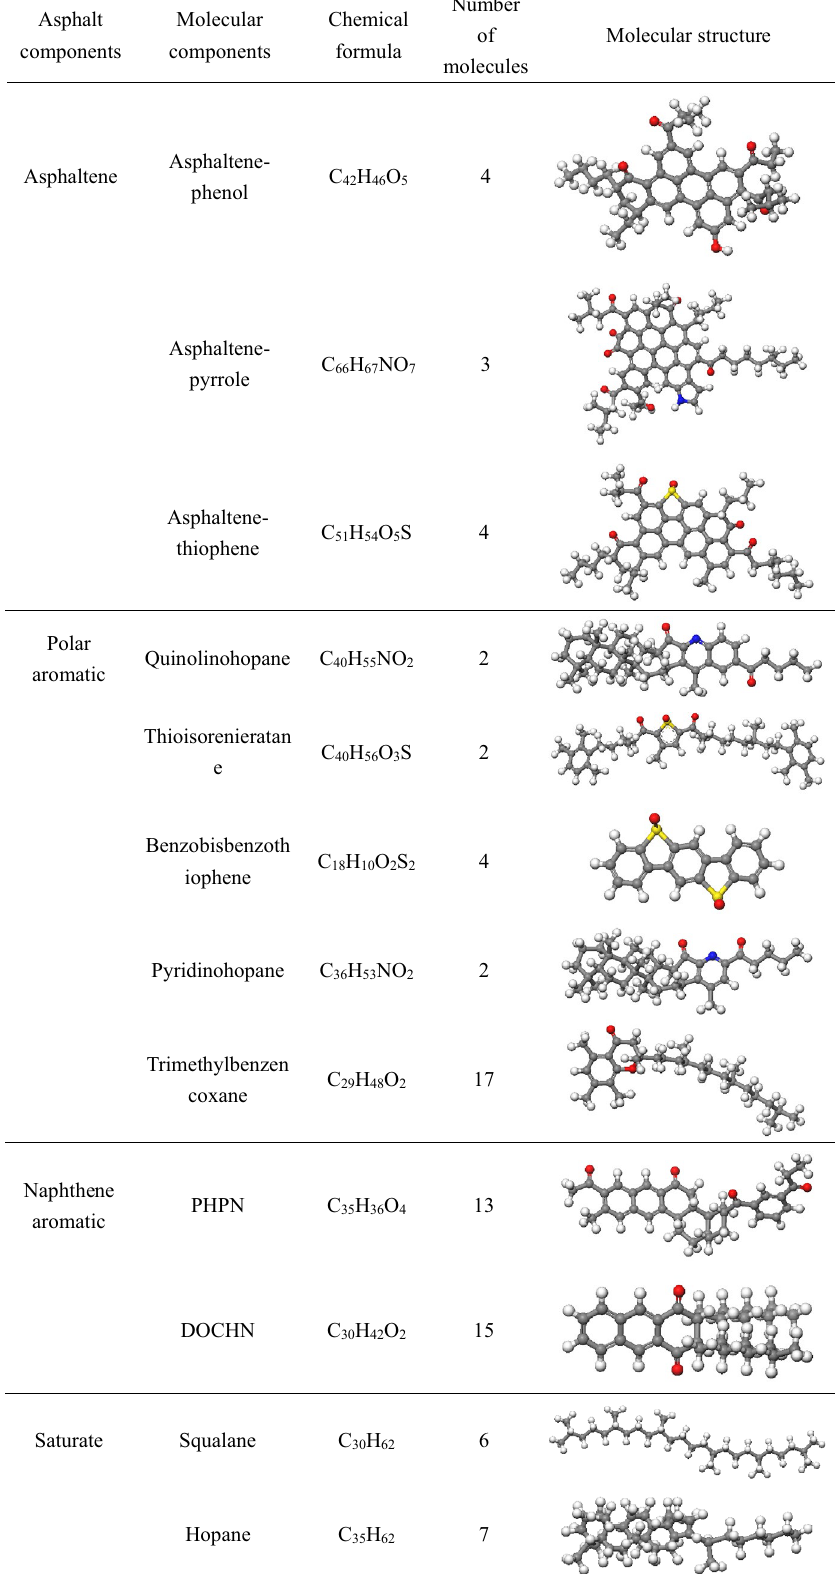
Table 2. Molecular composition of the aged